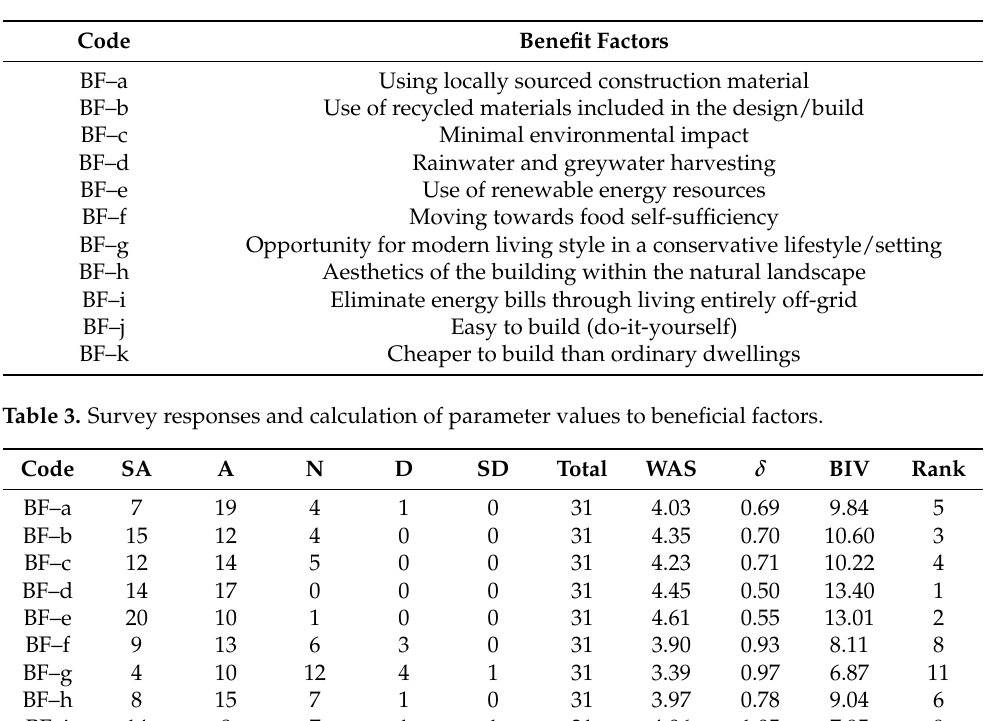
Table 2. List of beneficial factors.